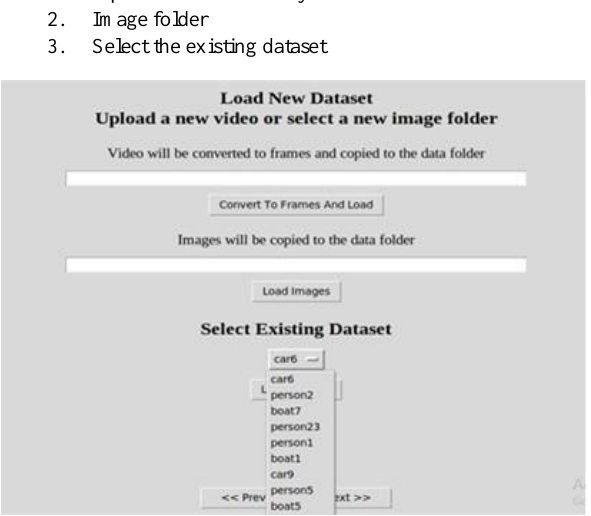
Figure 5. Loading data for single object tracking.